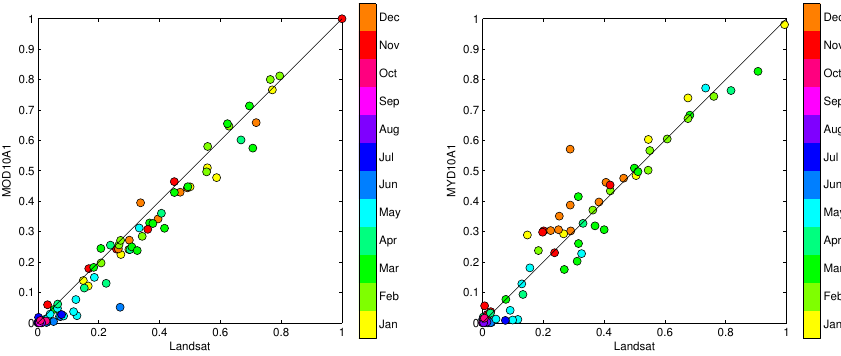
Figure 6. Snow coverage calculated from Landsat and MODIS snow products (Terra MOD10A1, Aqua MYD10A1) for 157 dates (139 dates for MYD10A1) distributed between 2002 and 2010 over the Pyrenees. The color indicates the month of the year. The snow coverage is defined as the fraction of the cloud-free area which is covered by snow in the study area (Fig. 1). For each date, the cloud-free area is defined as the intersection of the cloud-free areas in Landsat and MODIS products.